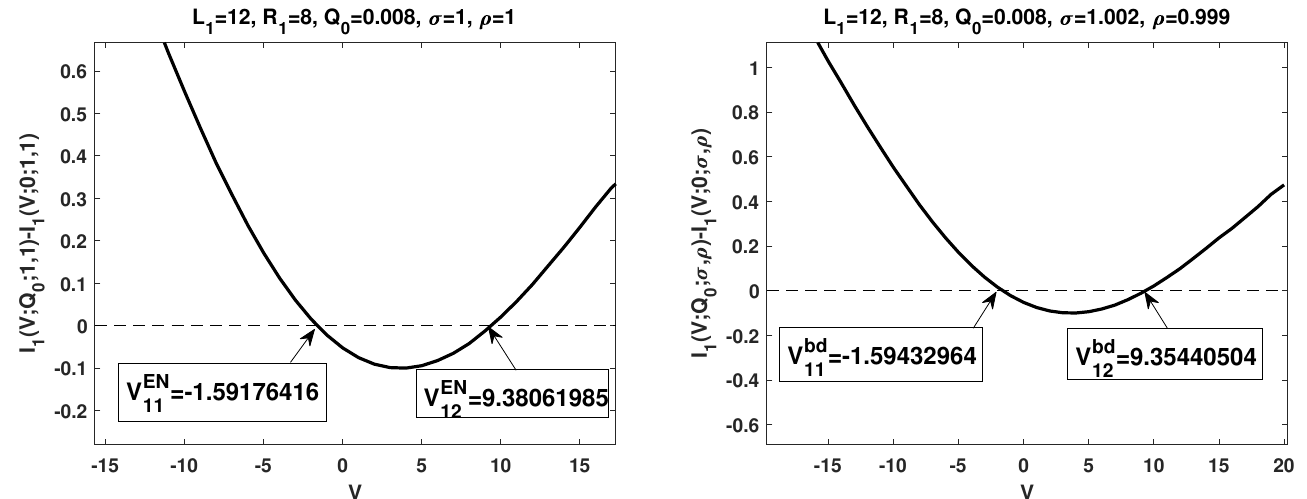
Figure 3. Numerical simulations of I 1 ( V ) , the first-order I–V relations in Q 0 for two different setups. The left figure is under electroneutrality boundary conditions, while the right one is with boundary